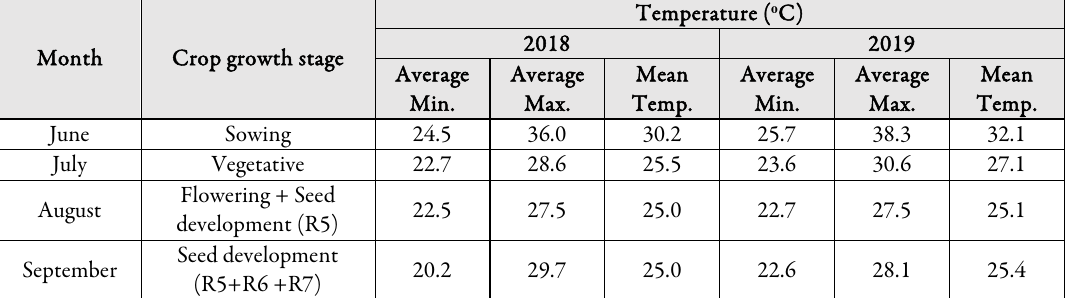
Table 3. Average minimum, maximum and mean temperature ( ᵒ C) during crop growth stages in